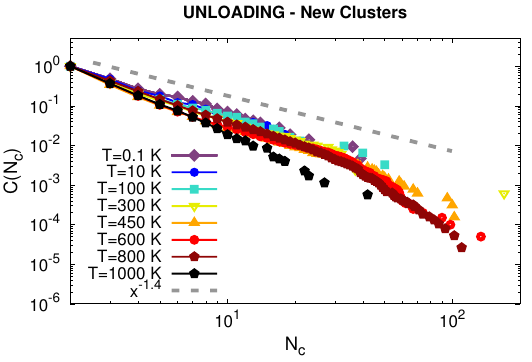
Figure 11. Complementary cumulative distributions C ( N c ) at different temperatures for the activated clusters upon unloading. The gray dashed line corresponds to a power law with exponent −